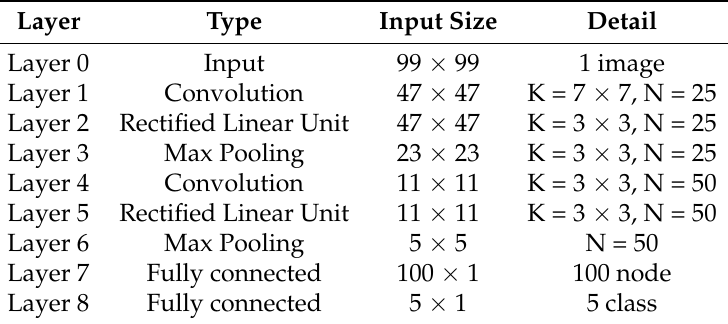
Table 5. Details of the proposed CNN layer detail.